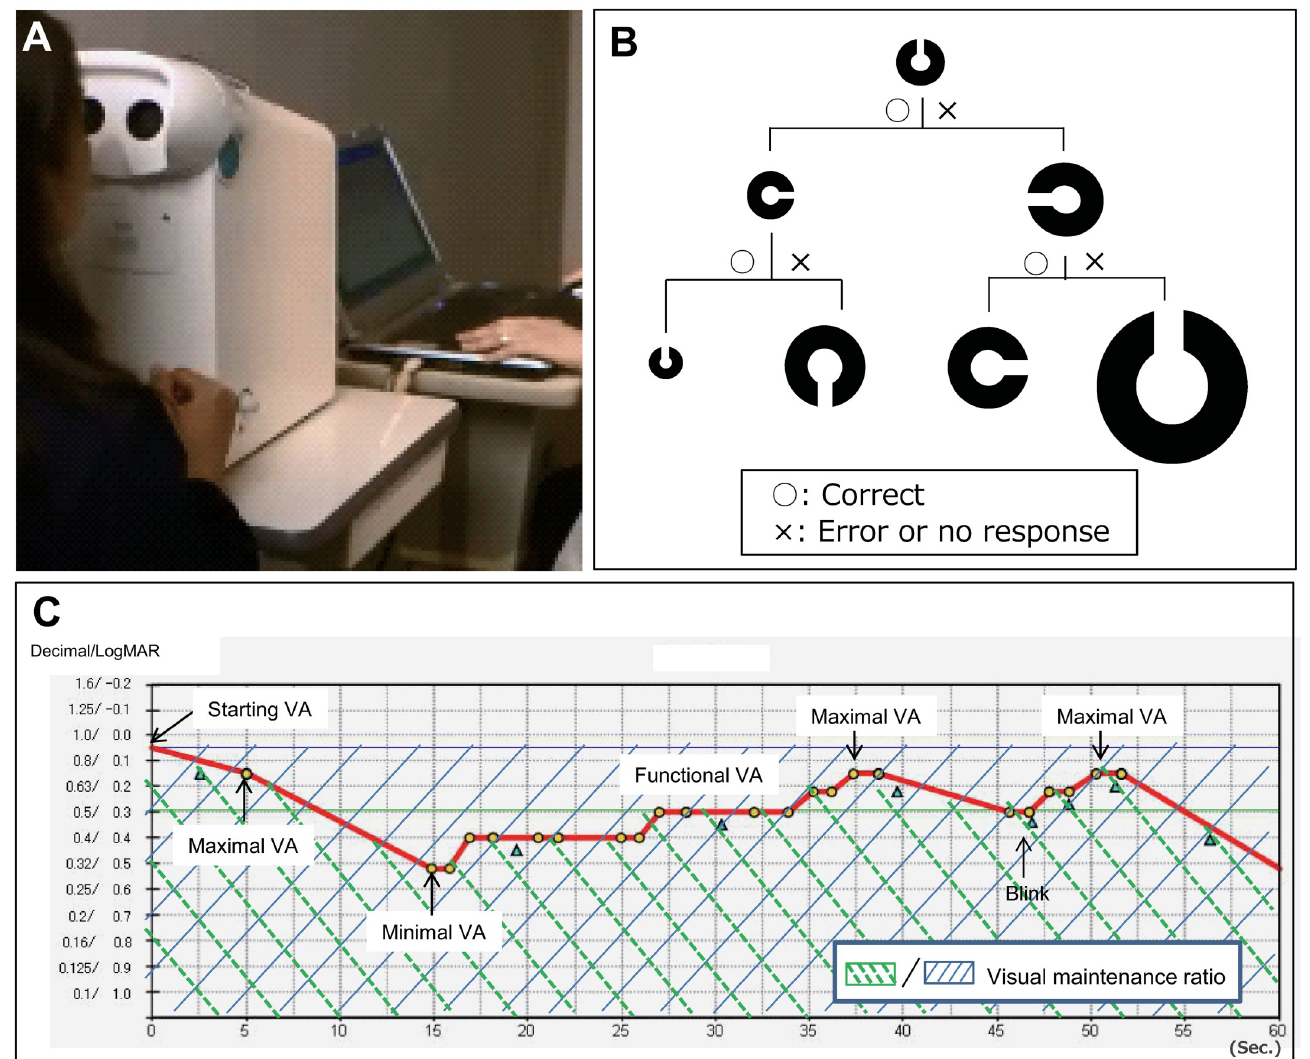
Fig 1. Functional visual acuity measurement system. (A) Equipment (AS-28) used to measure functional visual acuity. (B) Optotype display on the functional visual acuity system. (C) The results presented in graphical form. VA, visual acuity; logMAR, logarithm of the minimum angle of